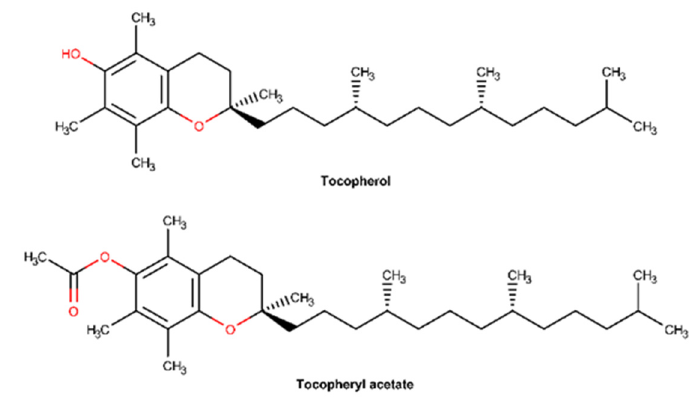
Figure 11. Chemical structure of tocopherol and tocopheryl